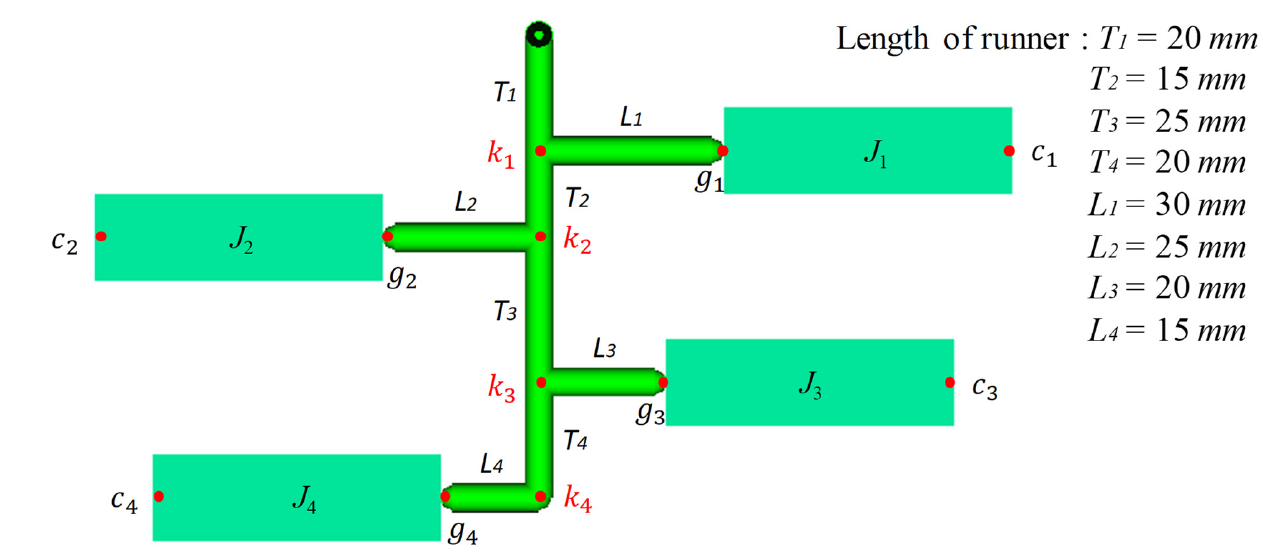
Table 2. The runner diameter, volume, and injection pressure of the 8-cavity mold (a half model) before and after optimization .